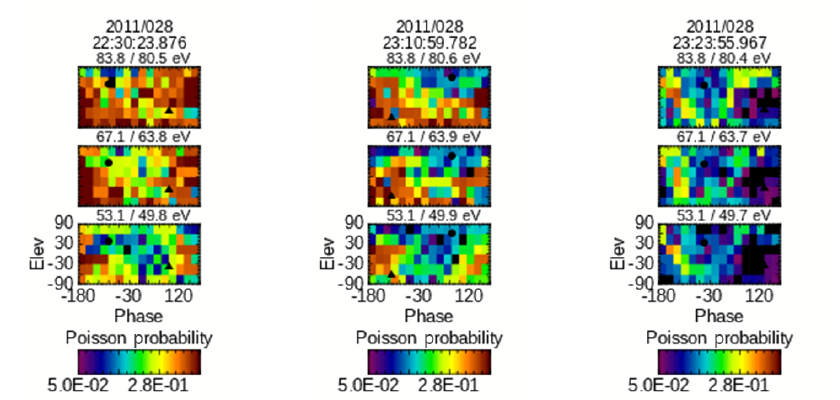
Figure 13. φ – θ plots of the Poisson statistics associated with the top three energy steps in each of the three columns in Fig. 11.